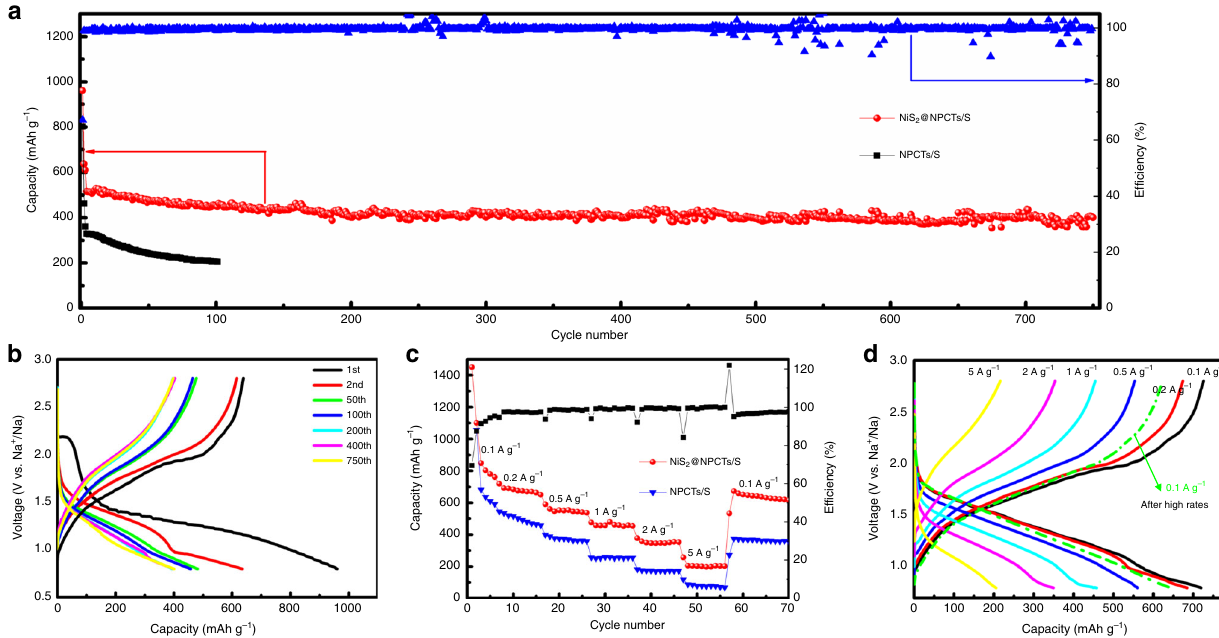
Fig. 2 Room temperature sodium-sulfur battery test. a Cycling performance of NiS 2 @NPCTs/S (red) and NPCTs/S (black) at a current density of 1 A g − 1 . b The corresponding charge/discharge pro fi les of NiS 2 @NPCTs/S at different cycles. c Rate capability at 0.1, 0.2, 0.5, 1, 2, and 5 A g − 1 for NiS 2 @NPCTs/S (red) and NPCTs/S (blue). d The corresponding charge/discharge pro fi les of NiS 2 @NPCTs/S at different current